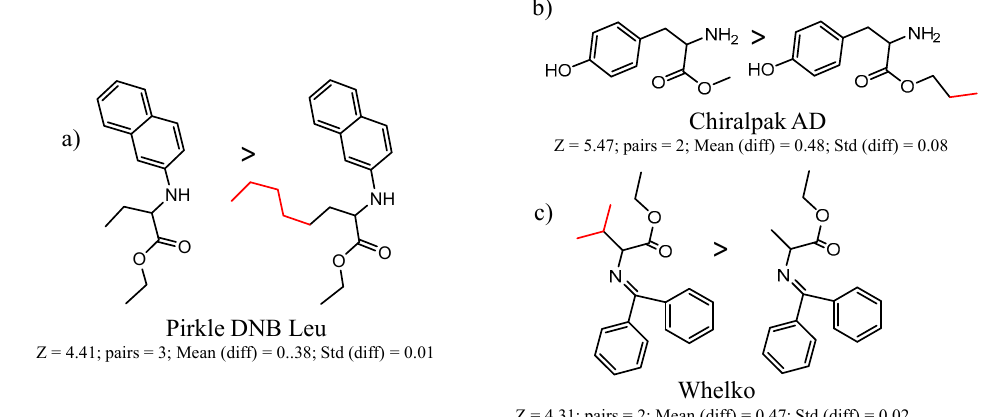
Figure 5. Matched Molecular Pairs illustrating effects of chain length and steric bulk on chiral recognition.